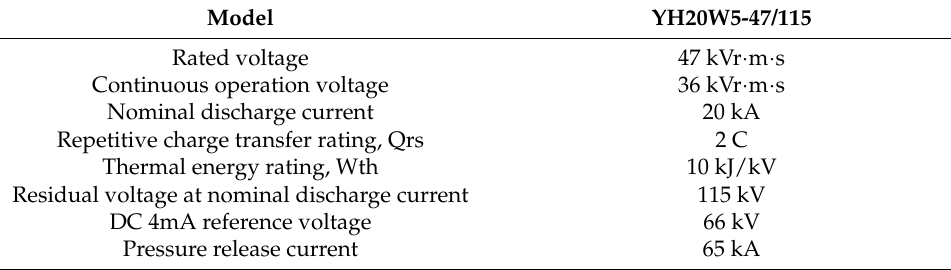
Figure 3. Schematic diagram of typical fault conditions in DC transmission systems. Table 3. Basic parameter of multicolumn parallel zinc oxide arresters.